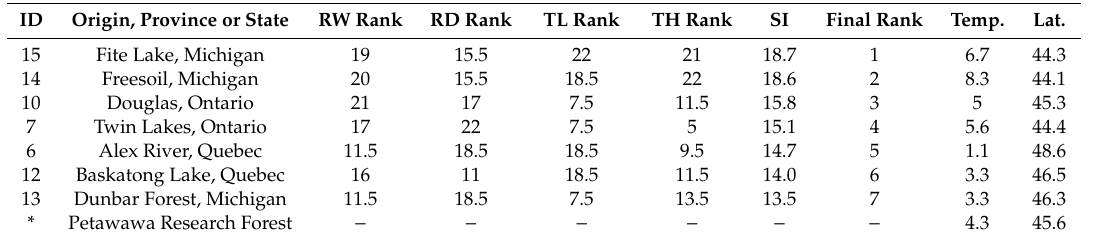
Table 4. Top seven provenances when ranked in order of selected wood quality attributes and as cumulative selection index among these selected wood quality